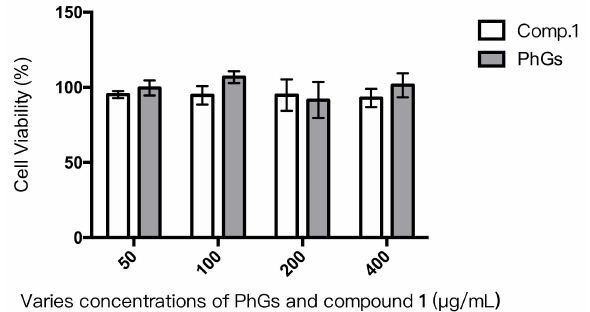
Figure 3. Cell viability of phenylethanoid glycosides (PhGs) and compound 1 on INS-1